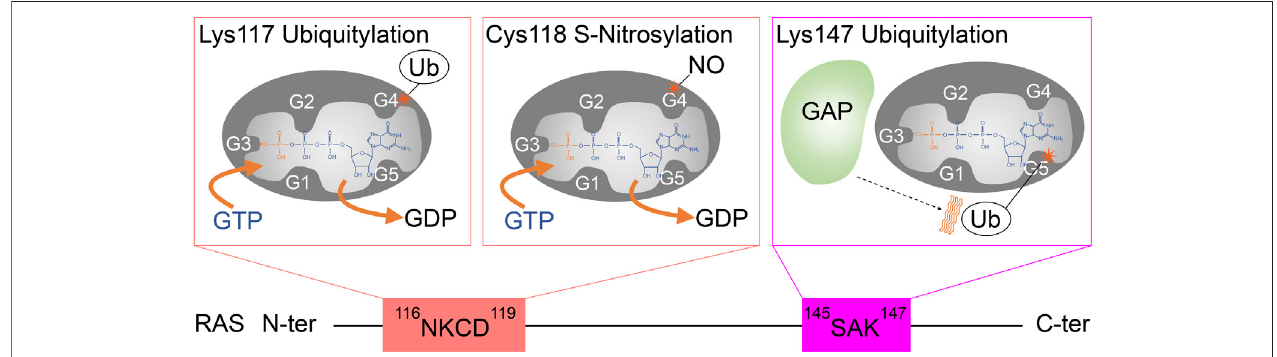
FIGURE5| AschematicdiagramhighlightingtheroleofG4andG5post-translationalmodi fi cationsinRASactivation.MonoubiquitylationofRASatLys117,aswell as S-nitrosylation of RAS at Cys118, increases GDP dissociation, leading to an increased GTP/GDP exchange rate. In contrast, monoubiquitylation of RAS at Lys147 impedes GAP-mediated GTP hydrolysis, which populates the active RAS GTP-bound “ ON ” state.